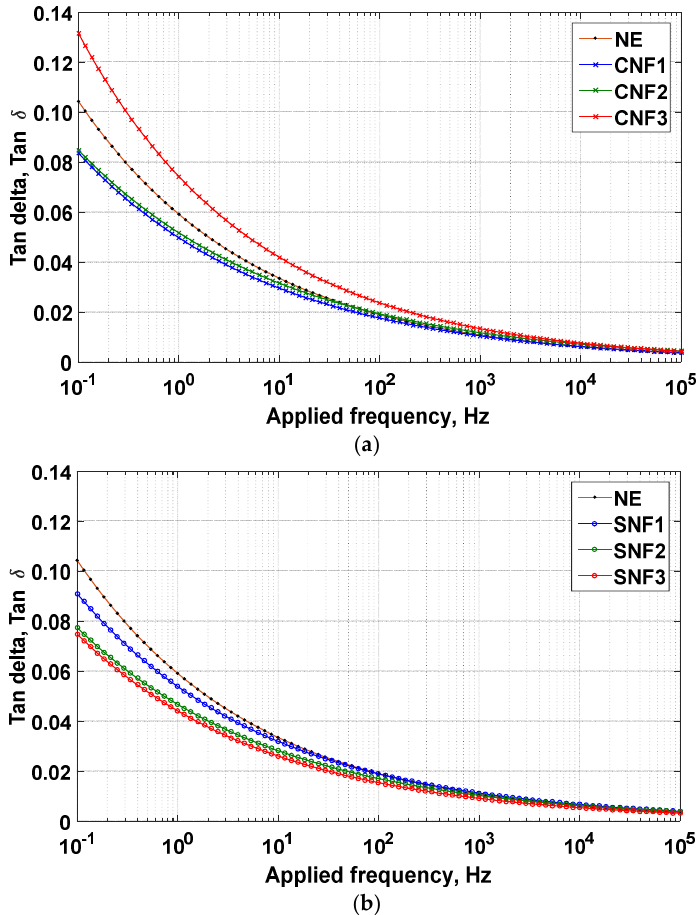
Figure 3. Tan delta as a function of applied frequency for ( a ) CNF and ( b ) SNF samples.